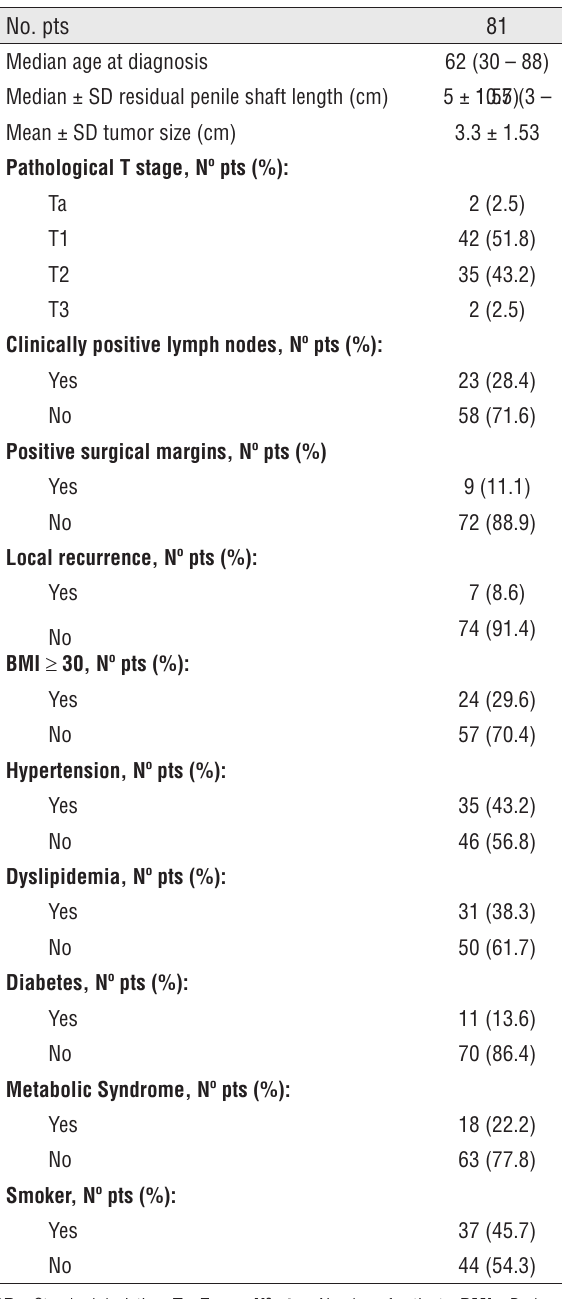
Table 1 - Baseline clinical and pathological